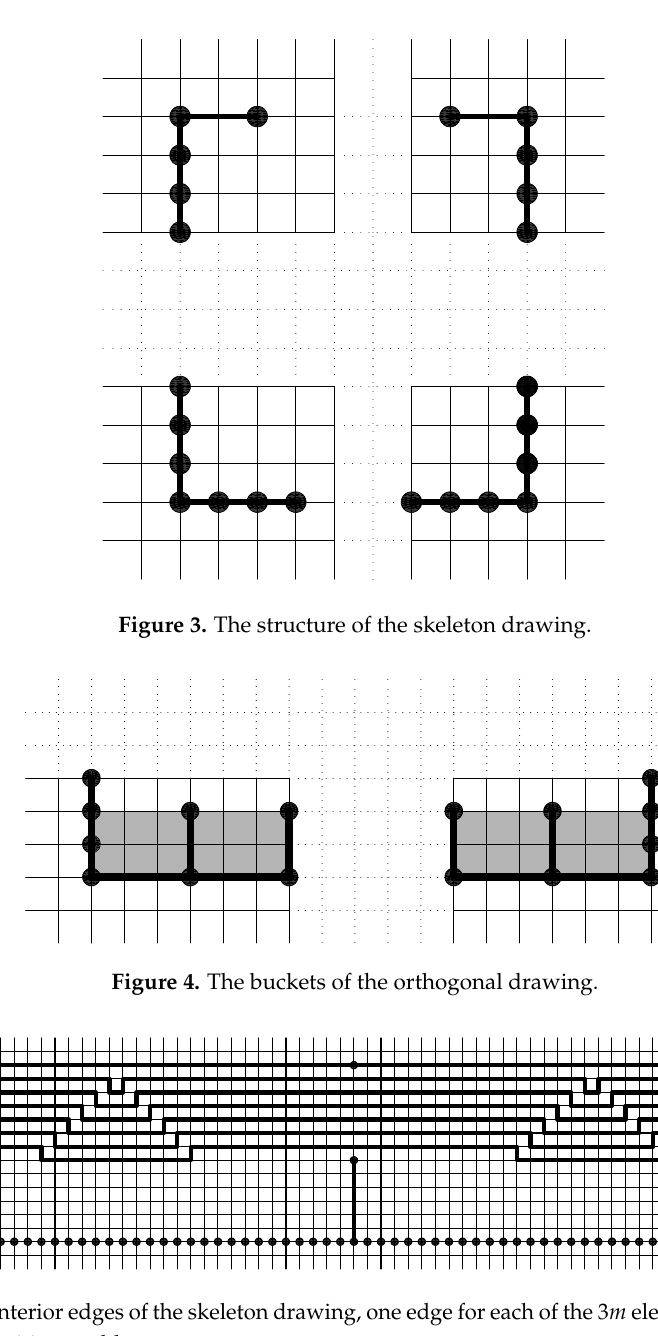
Figure 5. The interior edges of the skeleton drawing, one edge for each of the 3 m elements of an instance of the three-partition